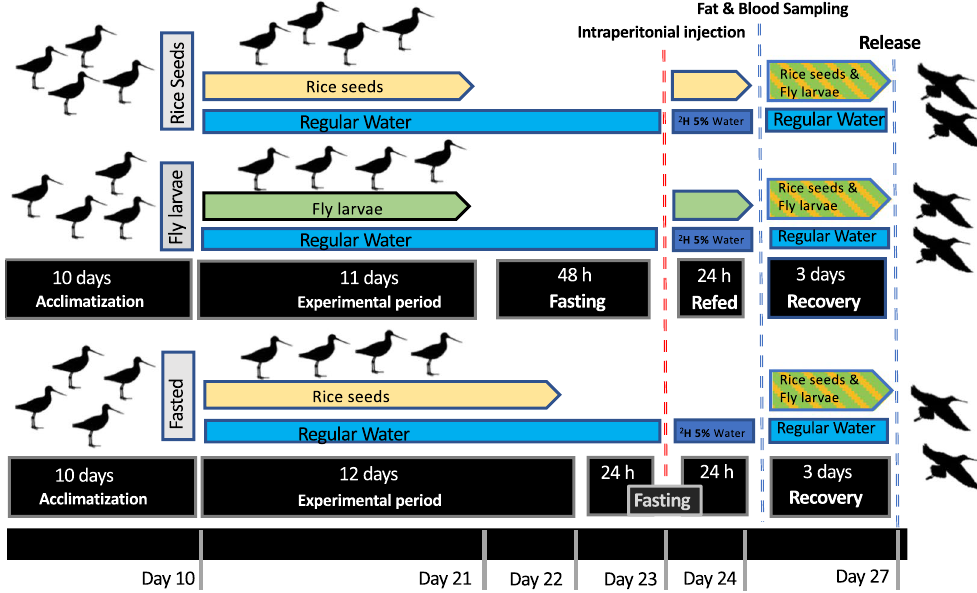
Figure 1. Schematic representation of experimental design from the capture of black-tailed godwits in the Extremadura rice fields onwards (Badajoz,